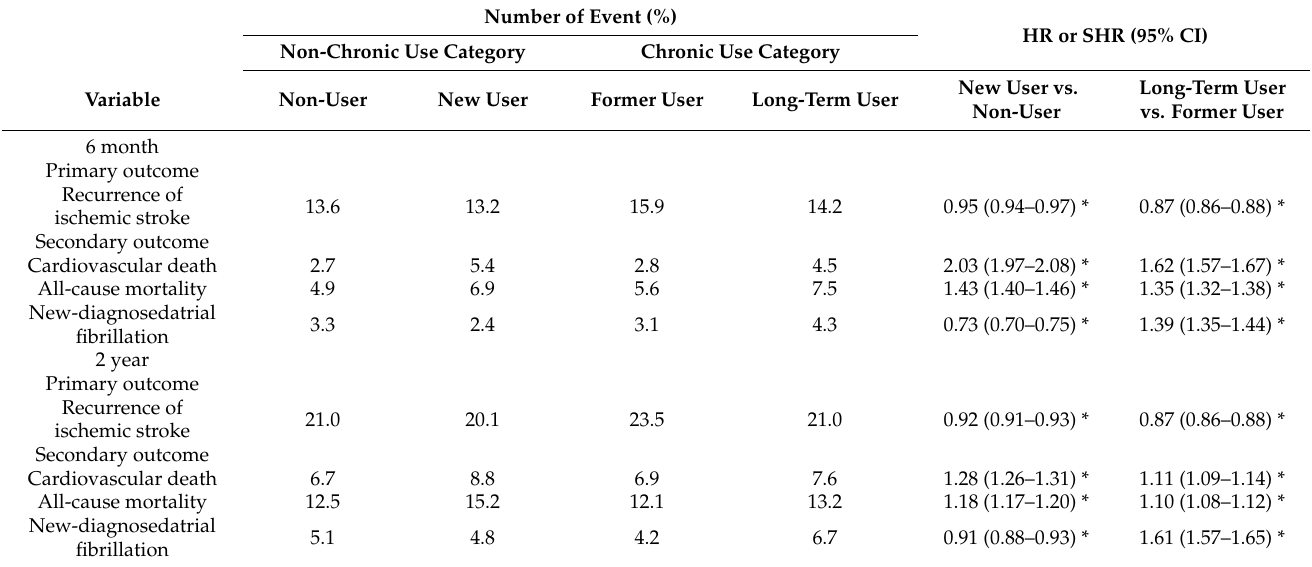
Table 2. Long-term outcomes of study patients after IPTW.